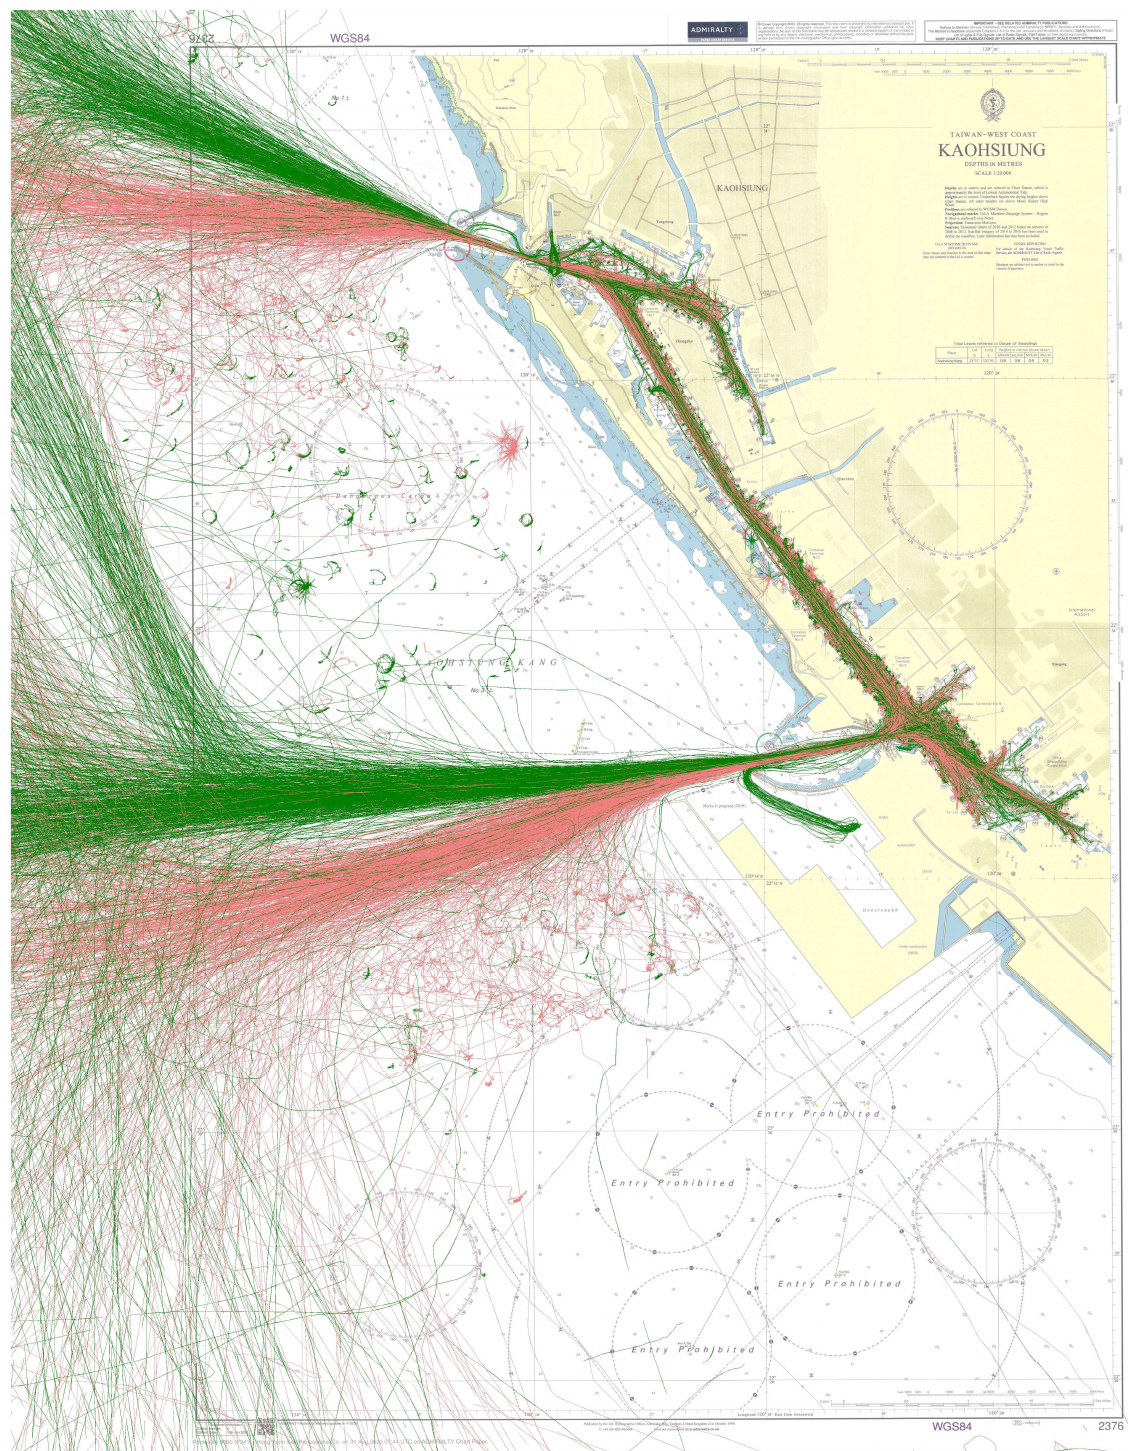
Figure 2. The traffic flows of vessels entering/exiting the Kaohsiung port. Note: the red line means ship track (enter); the green line means ship track (exit); the yellow area means land; the light blue area means coastal line.